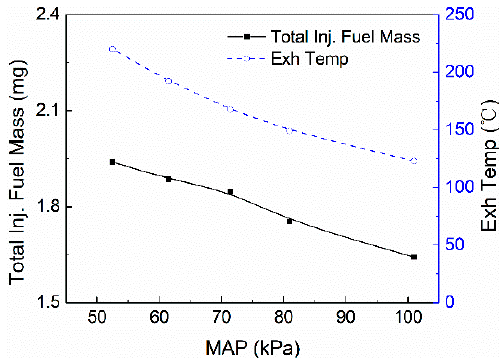
Figure 3. Total injected fuel mass and exhaust temperature under the various MAPs.